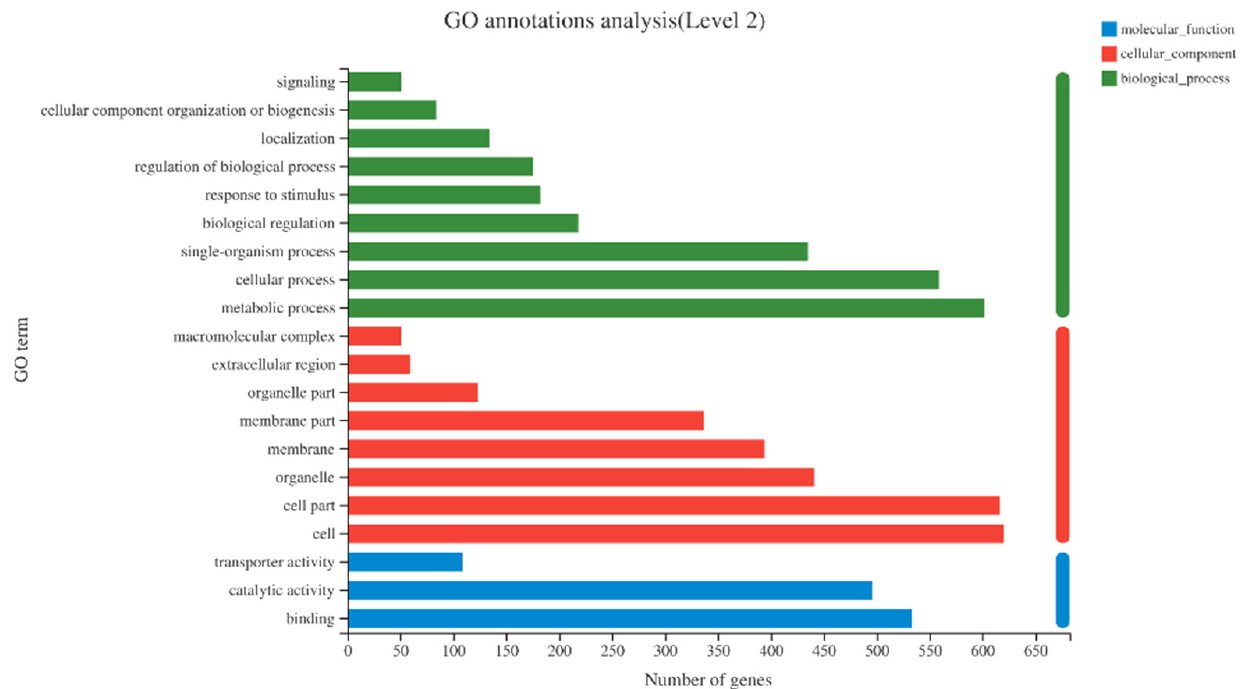
Figure 4. Histogram of GO classification statistics of differentially expressed genes. The vertical axis in the figure represents the secondary classification term of GO, and the horizontal axis represents the number of genes in the secondary classification.